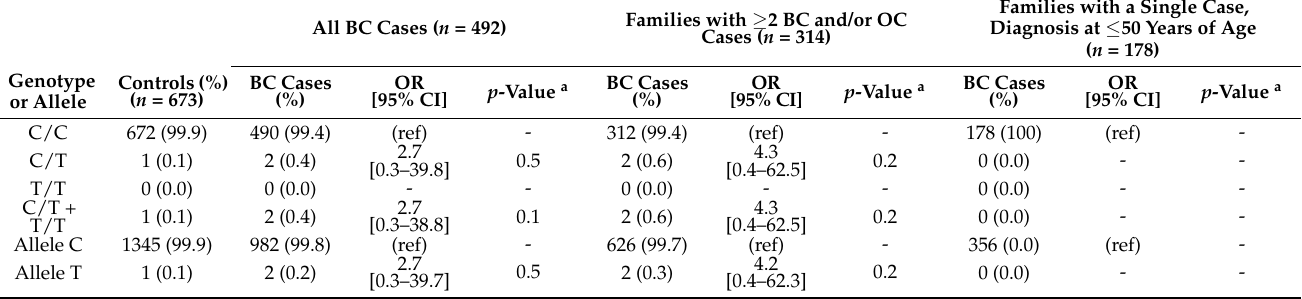
Table 1. Genotype and allele frequencies of rs144567652 (FANCM) in BRCA1/2-negative breast cancer cases and